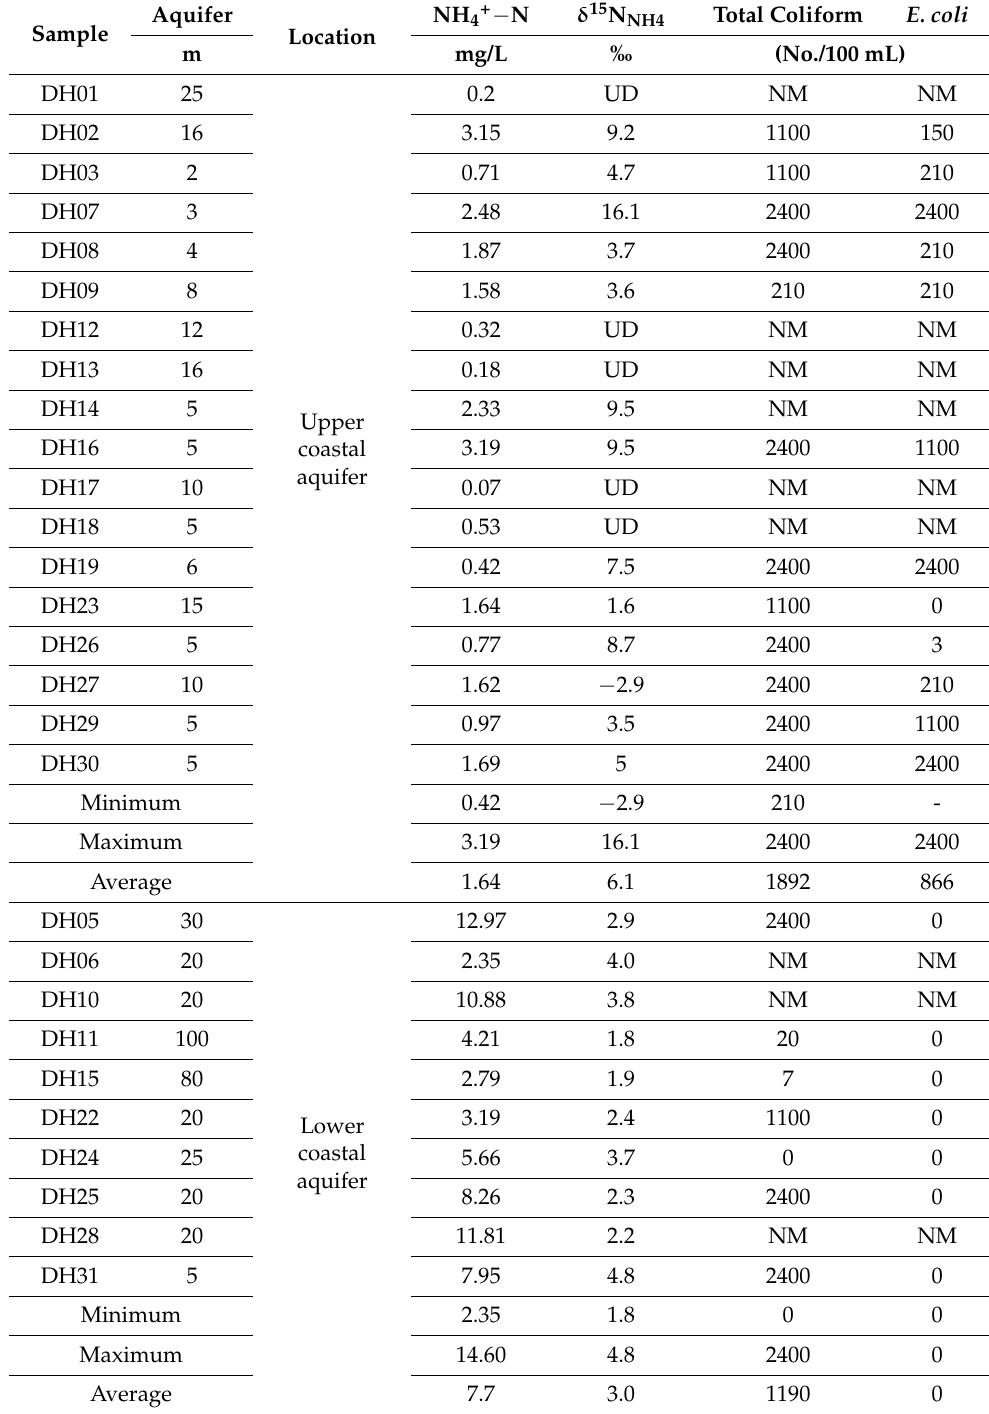
Table 1. NH 4+ − N concentrations, δ 15 N NH4 values, and coliform